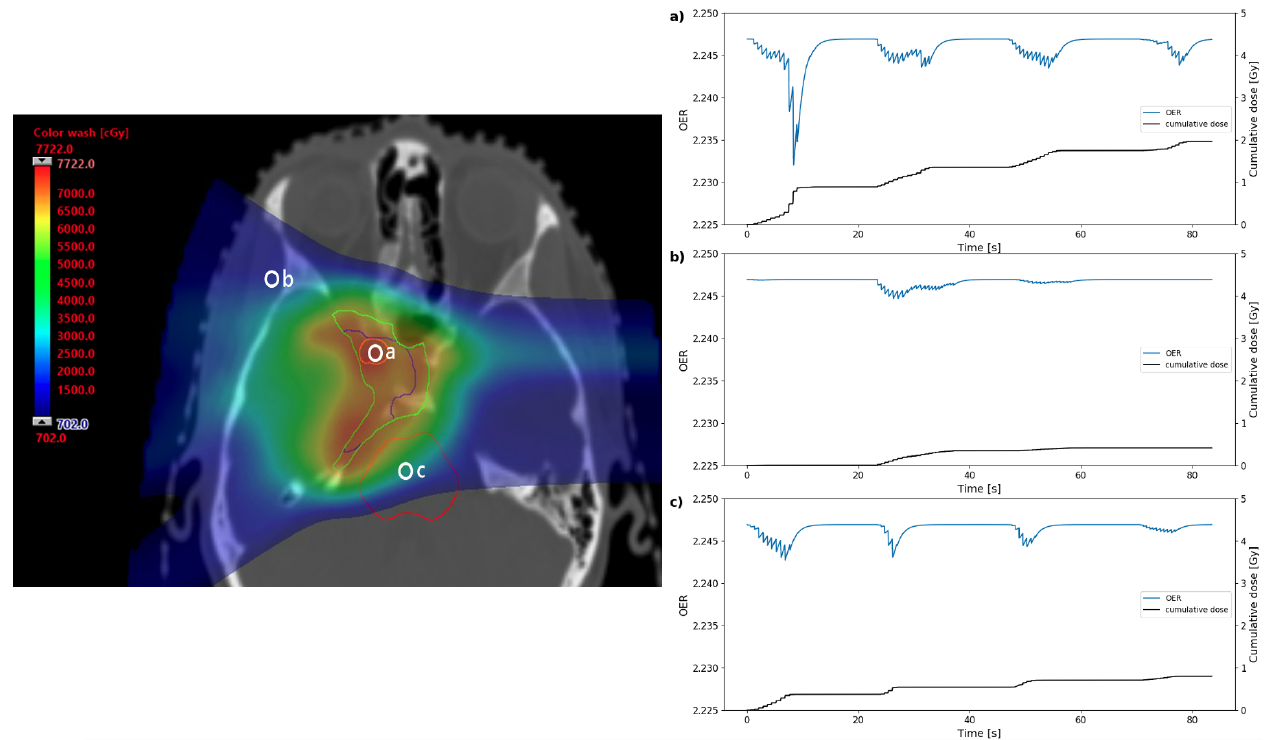
Figure 3. Dose distribution (left) for the clinical base of skull plan in Figure 2 annotated to show three points where OER data were simulated. The plots (right) show the change in OER and the cumulative dose over the duration of the simulated treatment for the three points in the plan: ( a ) within the GTV, ( b ) in a beam entrance, or ( c ) in the brainstem. The blue line shows OER as a function of time for the node position at 25µm from the capillary in the oxygen diffusion model. The black lines show the cumulative dose at that point over the course of the